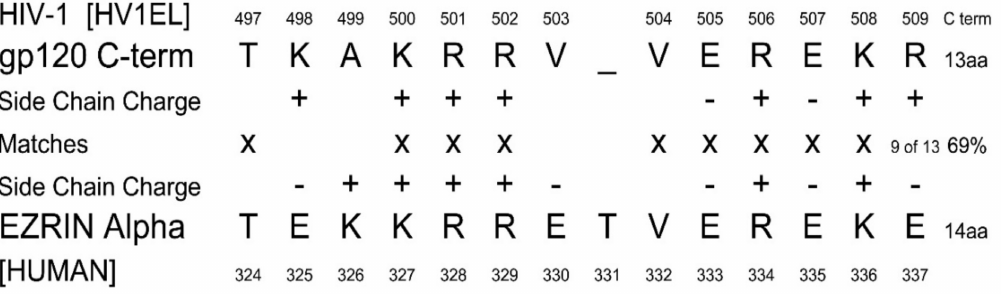
Figure 1. Homology of the mutation-stable C -terminus of HIV gp120 and the α domain of human